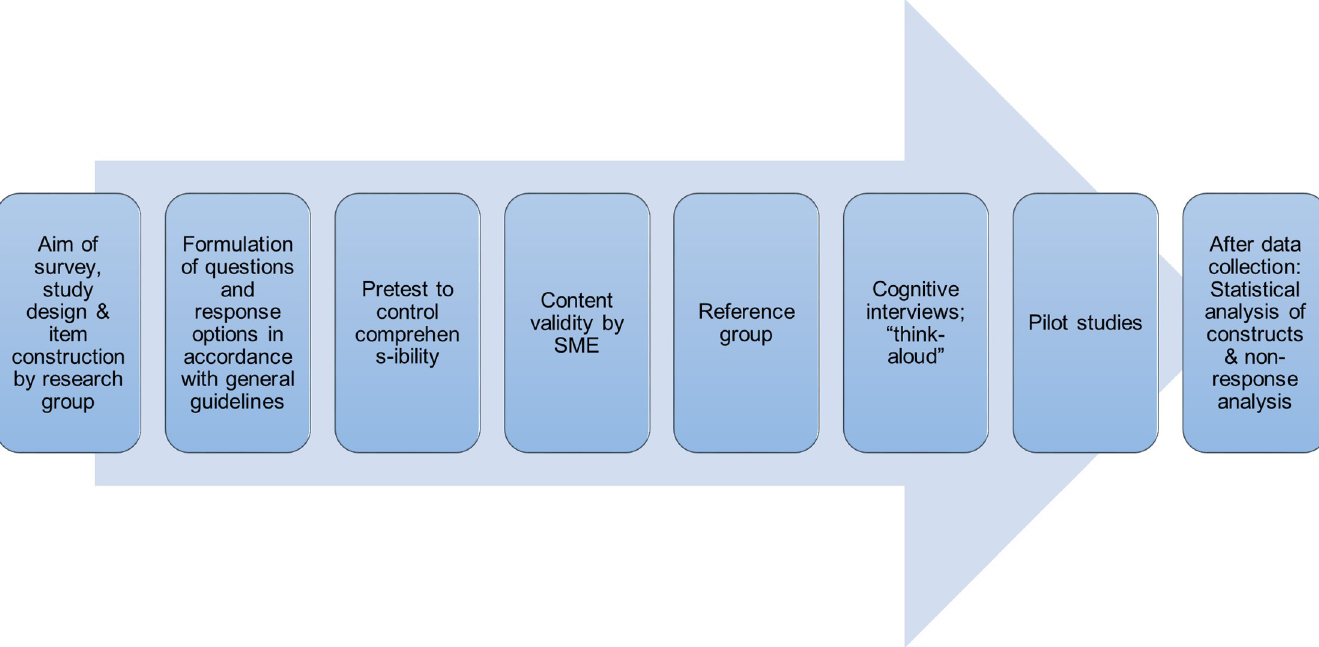
Fig 1. The validation process employed in the present study. Detailed information on number and order of items, construction of questions and response options are reported in the S2 Doc.